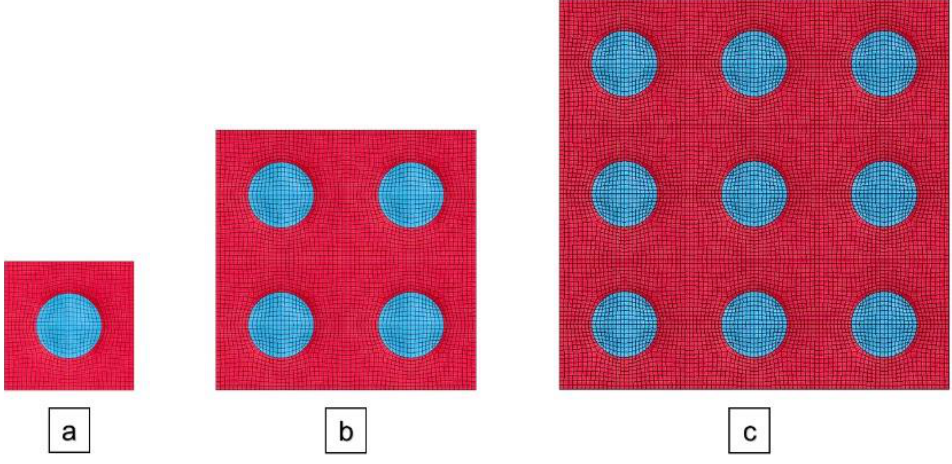
Figure 5. The middle sections of ( a ) 1-sphere, ( b ) 8-sphere, and ( c ) 27-sphere models. Table 6. Characteristics of different meso-scale model arrangements.